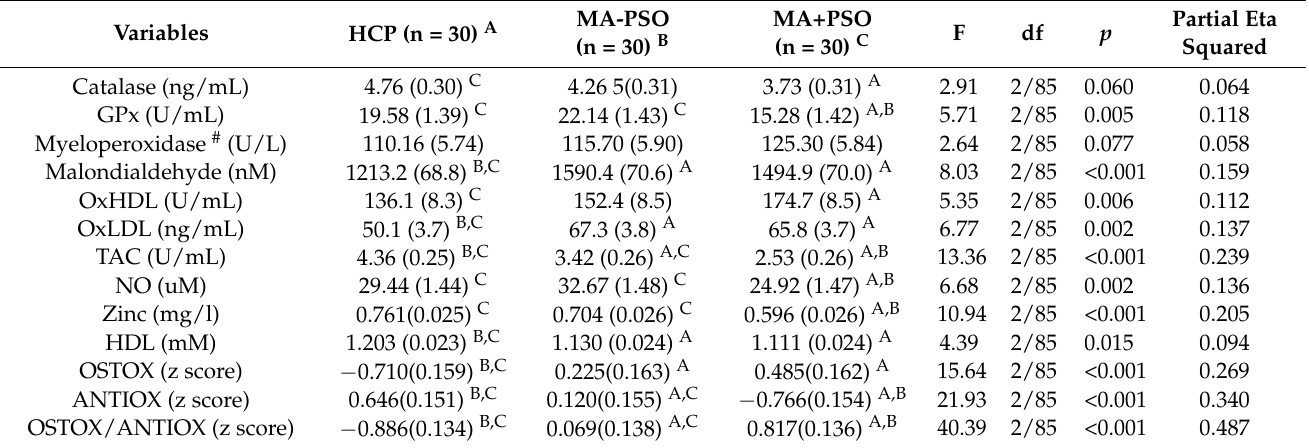
Table 3. Oxidative stress biomarkers in heathy control participants (HCP) and patients with metham- phetamine abuse (MA) classified into those with (MA+PSO) and without (MA-PSO) increased psychotic symptoms and oxidative stress